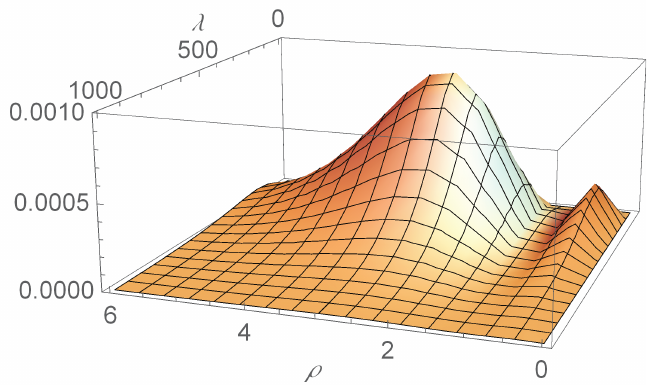
Figure 1. The radial distribution densities W ( ρ ) and W ( λ ) for the state 2 S ( µ ) 1 S ( e ) . The variable values ρ and λ are presented in muonic atomic units.